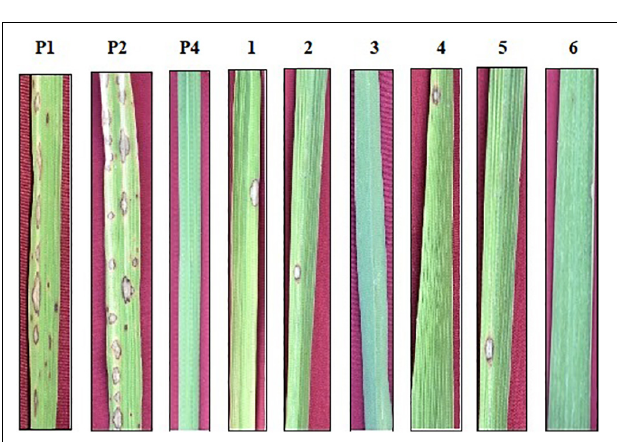
FIGURE 3 | Phenotypic screening of improved pyramided lines against IS (KUL)-6 isolate of Magnaporthe oryzae for leaf blast. P1 – ASD 16, P2 – ADT 43, P4 – Tetep; serially numbered 1, 2, 3, 4, 5, and 6 lines indicate improved pyramided lines of recurrent parents harboring the Pi54 gene.